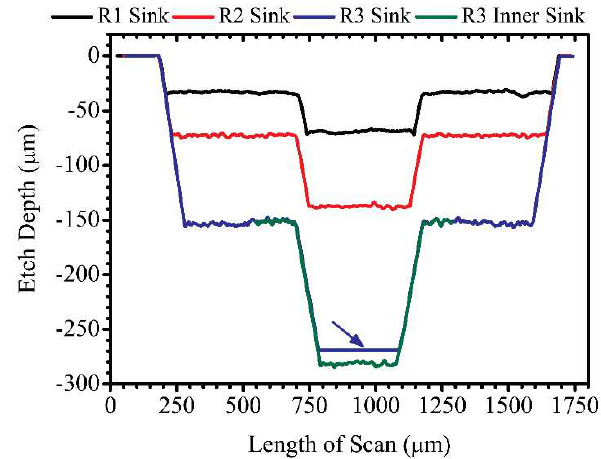
Figure 10. A plot of line profile scans across the circular sinks of the 3D multi-depth reservoir micromodel. The black, red, and blue traces correspond to the profiles of reservoirs R1, R2, and R3, respectively. The green trace was a repeated scan for reservoir R3 from the newly etched outer sink surface (layer 1) due to instrument limit which is observed as a smooth horizontal etch surface (indicated by blue arrow).